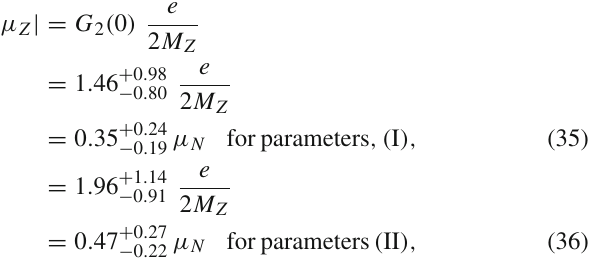
0 . 94 GeV − 2 . From the figure, we can see that the value of the G 2 ( 0 ) decreases monotonously with increase of the